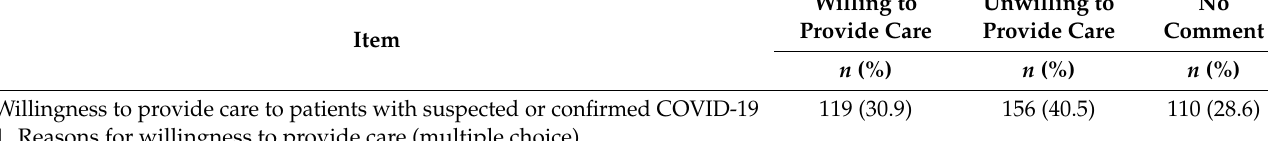
Table 1. Distribution of participants’ willingness to provide care to patients with COVID-19 ( n = 385).